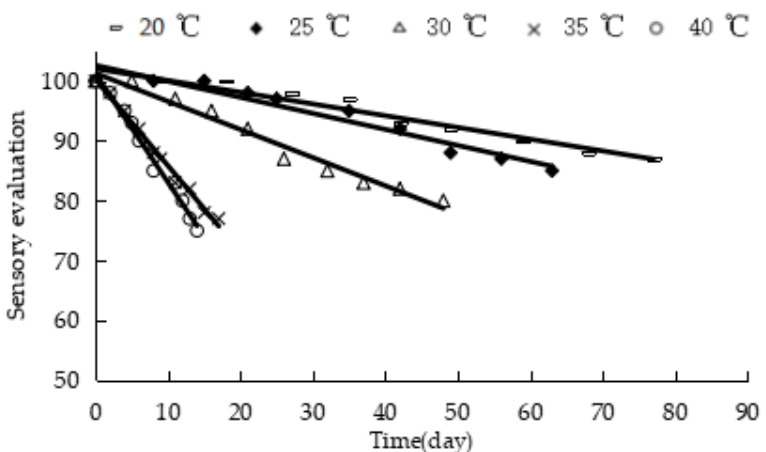
Figure 4. Response of the sensory evaluation of “boba” balls stored under different conditions. Table 3. The Arrhenius kinetic parameters of “boba” ball quality.